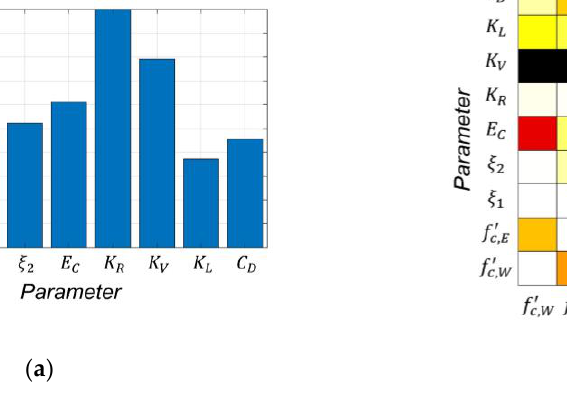
Figure 10. Identifiability analysis results: ( a ) relative information gain of the candidate unknown model parameters; ( b ) relative mutual information gain between the candidate unknown model parameter pairs. Each row is normalized to its diagonal value. Then, the diagonal values are nullified.